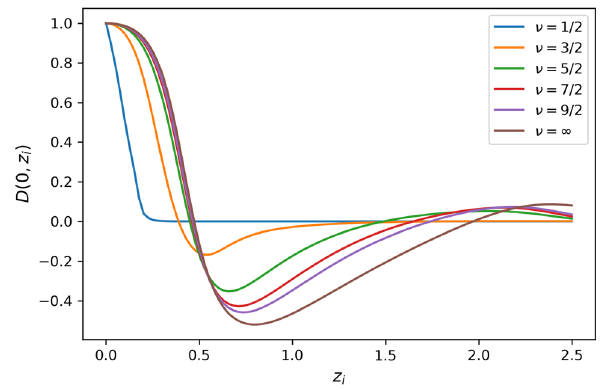
Fig. 2 Correlations between H ( z = 0 ) and H ( z i ) across a host of Matérn class kernels. The increase in the strength of correlations is directly reflected in the decreasing errors in Table 2 as ν is